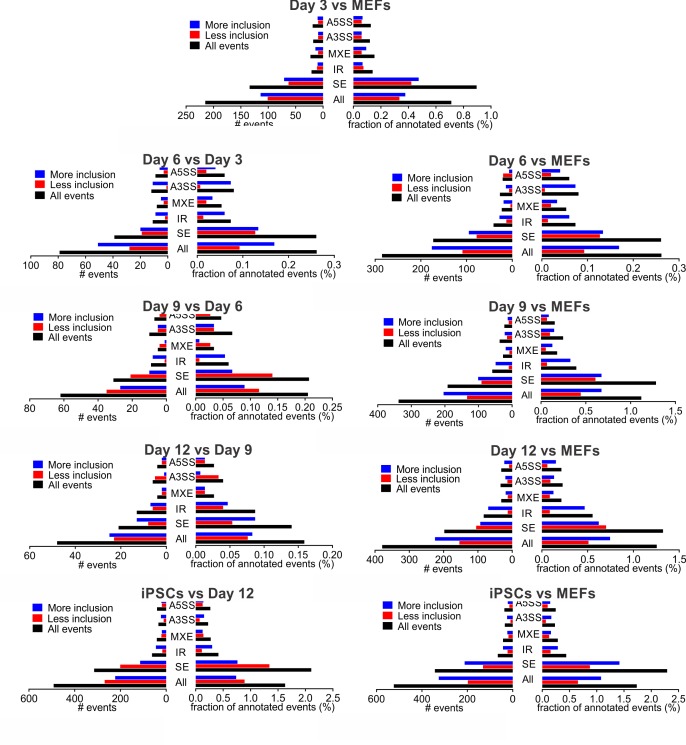
Alternative splicing during reprogramming.Changes in different alternative splicing (AS) types during reprogramming. AS changes in each of the reprogramming intermediates were quantified by MISO (ΔPSI ≥ |0.2| and Bayes factor ≥5) either by comparing to the previous time point (left, sequential) or MEFs (right, cumulative). SE, skipped exon; IR, intron retention; MXE, mutually exclusive exon; A3SS, alternative 3’ slice site; A5SS, alternative 5’ splice site.